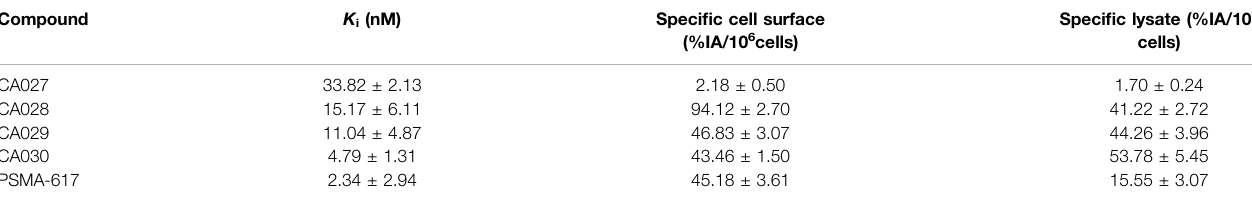
TABLE 2 | PSMA Inhibition Potencies (Expressed in K i values) and Speci fi c Internalization Values.